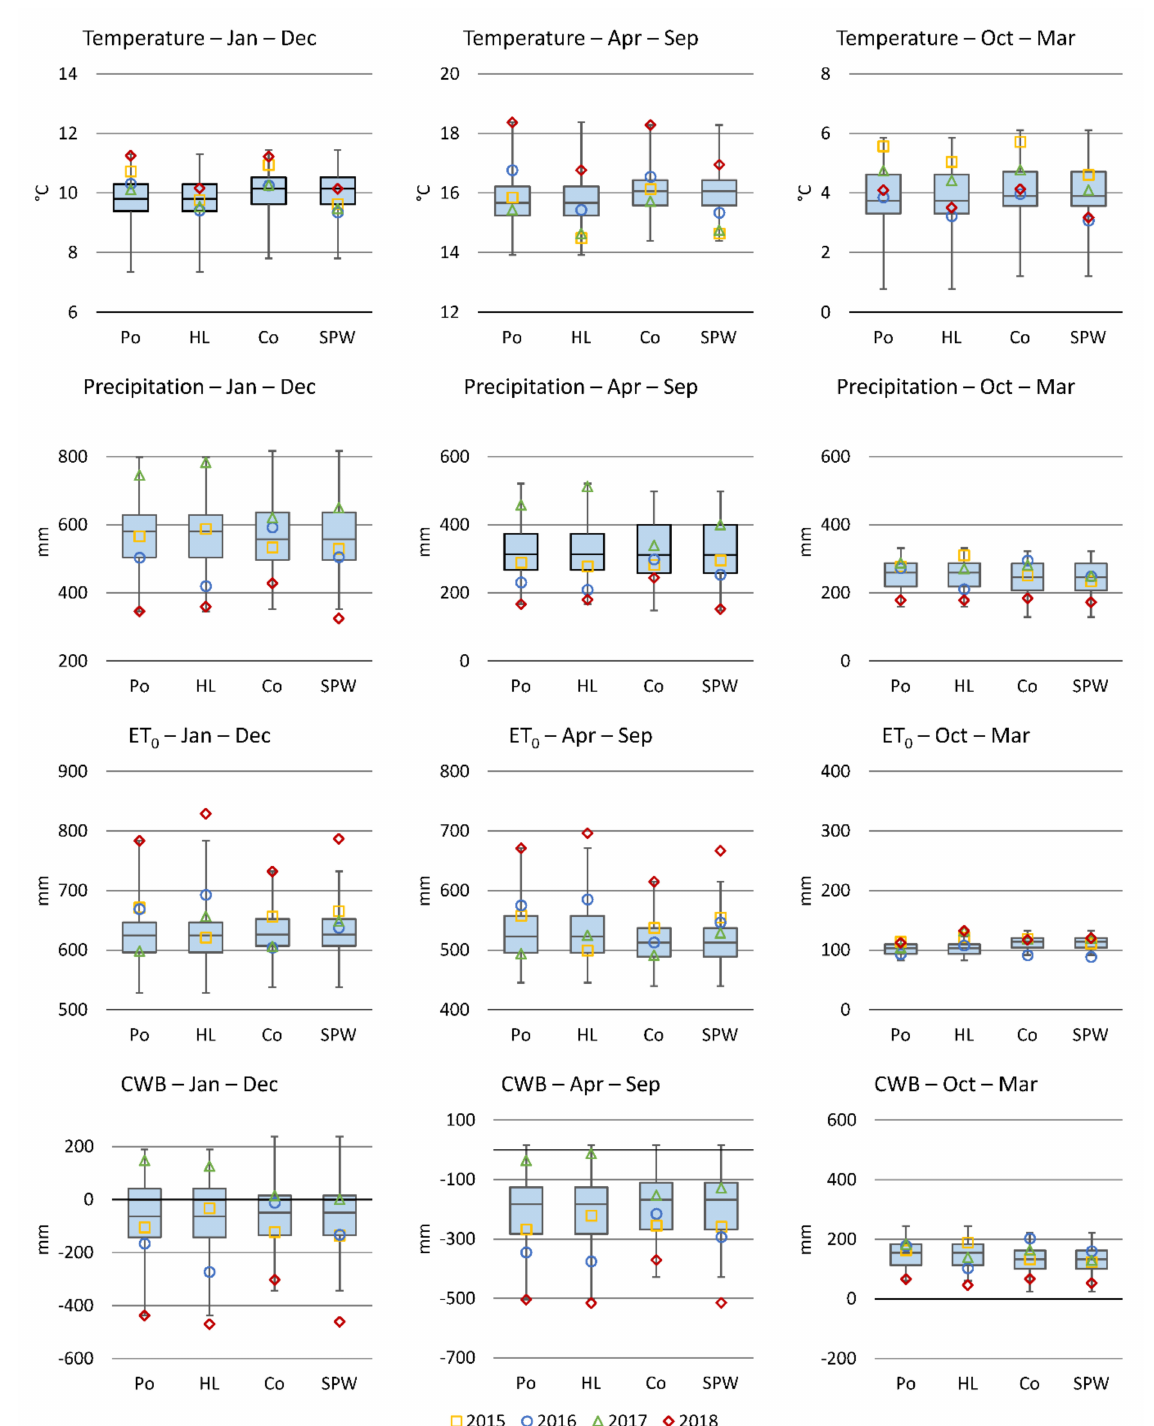
Figure 2. Classification of the key meteorological figures for the study years from 2015 to 2018 in the 30-year series from 1991 to 2020 (Po—whisker and years of Potsdam, HL—whisker of Potsdam and years of Havelländisches Luch, Co—whisker and years of Cottbus, SPW—whisker of Cottbus and years of Spreewald). The ranges of the precipitation values during the four years almost reach the ranges from the 30-year series. While the values for the year with the highest precipitation at the Potsdam station are almost reached in HL, the values for 2017 at SPW are only in the range of the 3rd quartile. Peak values reached in earlier years at the Cottbus station are still